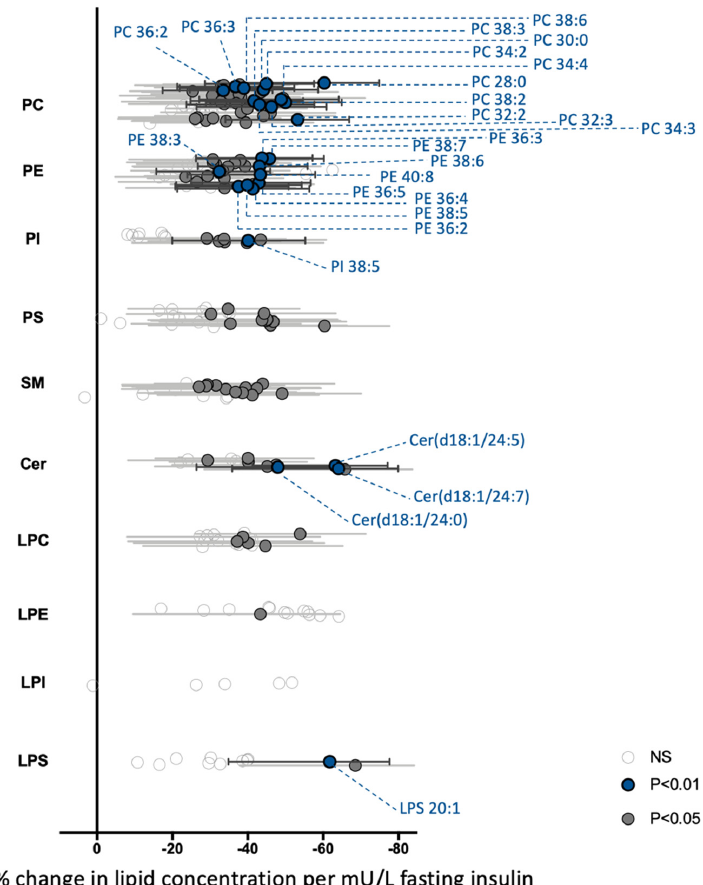
Figure 4. Association between fasting insulin and all detected PBMCs lipid species. Linear regression analysis between fasting insulin and each lipid species was performed on 14 lean, 18 OBNG and 25 OBDysG individuals adjusting for age. Gray open circles show lipid species with non-significant association with fasting insulin, dark gray and blue circles show species with significant association, p < 0.05 and p < 0.01, respectively, after correction for multiple comparisons (Benjamini- Hochberg). β -coefficients and 95% confidence intervals were then converted to percentage change (percentage change = (10^ β -coefficient − 1) × 100) for interpretation of results.